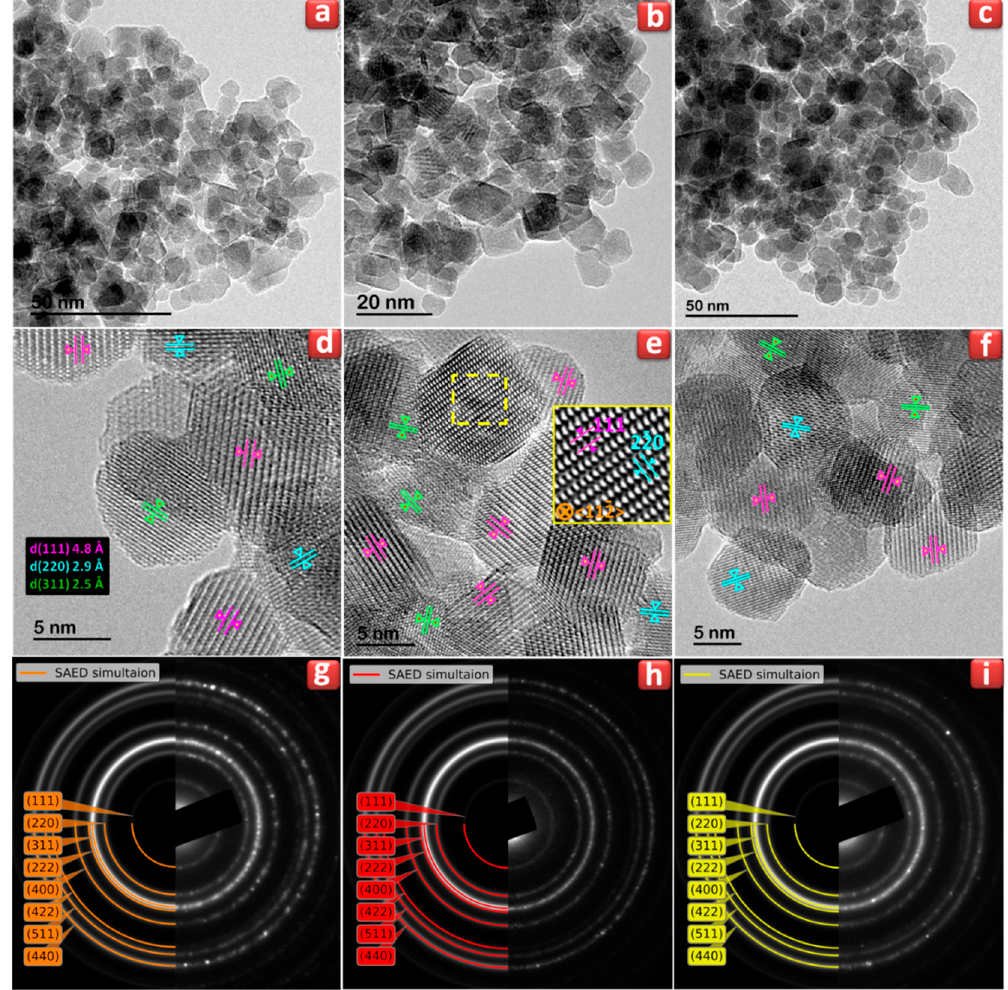
Figure 4. ( a–c ) TEM images; ( d–f ) HRTEM images; and ( g – i ) selected area electron diffraction (SAED) patterns (right) with the simulated ones (left) for Co_0, Co_2 and Co_4 samples.